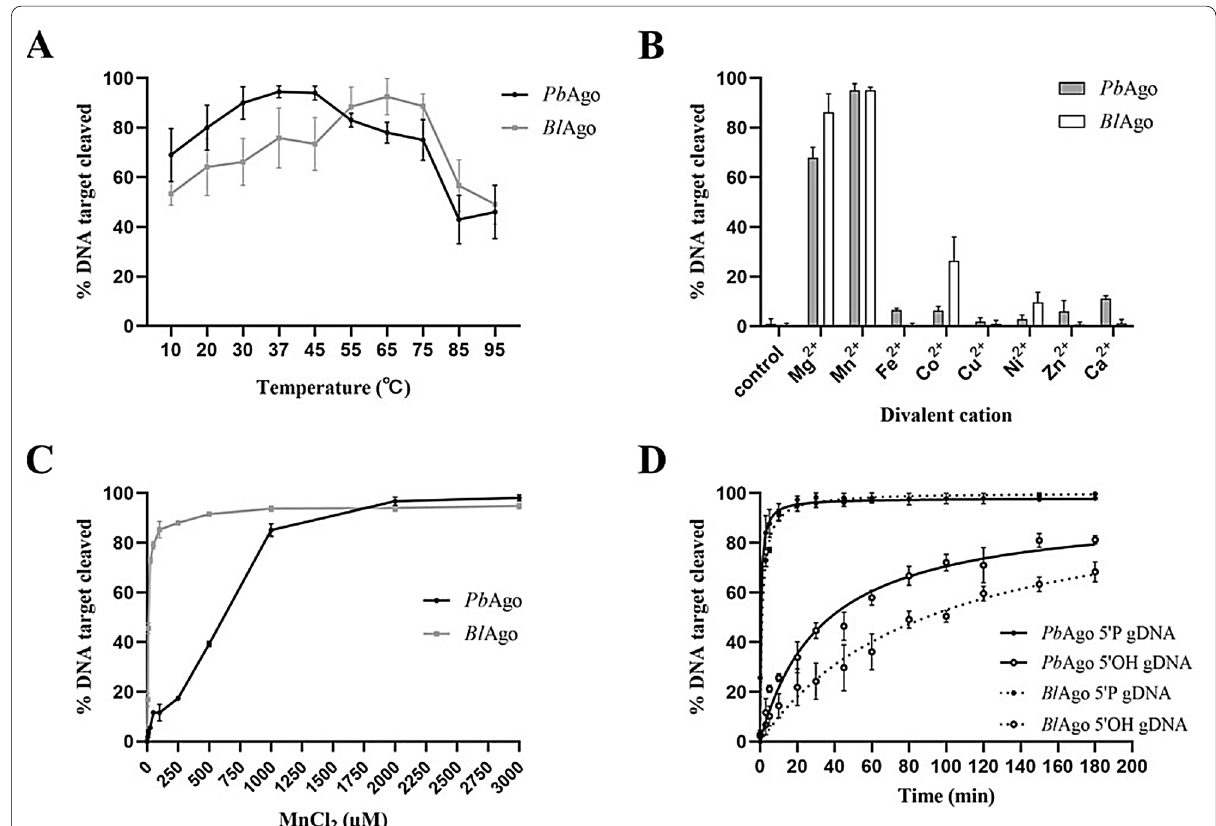
Fig. 2 Enzymatic characterization of Pb Ago and Bl Ago in vitro guided by the 5 ′ -P ssDNA. a Effect of temperature on Pb Ago and Bl Ago activity mediated by the 5 ′ -P gDNA. b Effects of different divalent cations on Pb Ago and Bl Ago activity mediated by the 5 ′ -P gDNA. c Effects of Mn 2 + concentrations on Pb Ago and Bl Ago activity mediated by the 5 ′ -P gDNA. d Kinetic performance of Pb Ago and Bl Ago mediated by 5 ′ -P and 5 ′ -OH gDNAs. Error bars represent the SDs of three independent